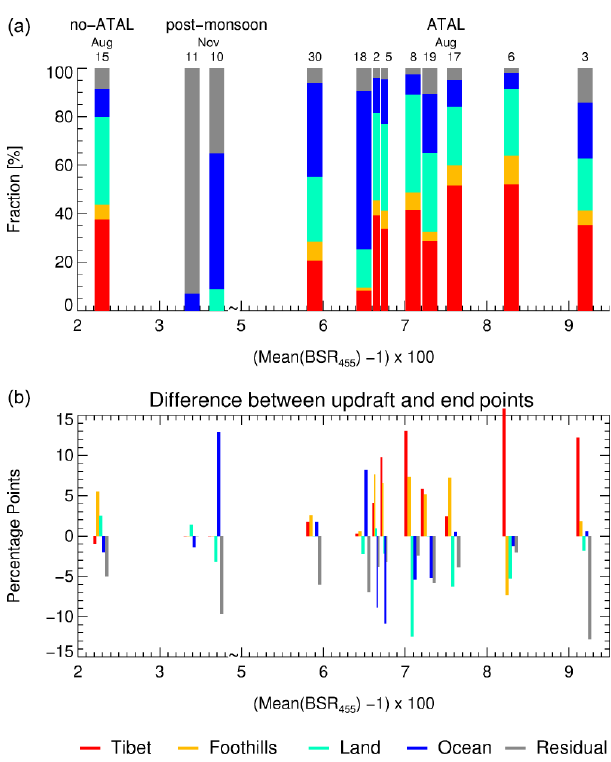
Figure 14. Contributions of Tibet, Foothills, Land, Ocean and Residual to the boundary layer (BL) sorted by increasing backscat- ter ratio ((BSR 455 − 1) × 100) (see Tables 1 and 3) for 40-day back- ward trajectories (a) . The contributions are normalised by the total number of trajectories within the boundary layer for each day. The days of the soundings in August and November are indicated above the top of the bars. For better representation, the range between 4.0 and 5.0 is removed from the x axis. The flights (11, 21, 23 and 26 August) for which the trajectory number is lower than 50% of the maximum number of trajectories (704) calculated on 18 August 2016 are not shown as well as the 12 August, when the UTLS is filled by a 5km thick cirrus cloud. The difference between the lo- cation of the end points and the location of strongest updraft (b) for 40-day backward calculations is also